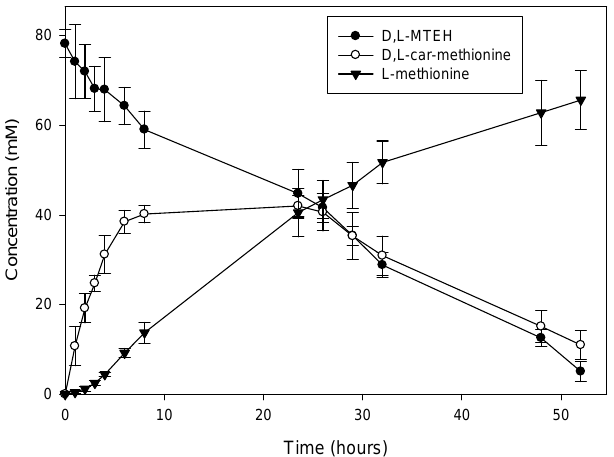
Figure 5. Conversion curves of D , L ‐ 5 ‐ methylthioethylhydantoin into L ‐ methionine by immobilized biocatalyst on IB ‐ 350 (Cycle 1). ( ● ) D , L ‐ 5 ‐ methylthioethylhydantoin, ( ○ ) N ‐ carbamoyl ‐ D ‐ methionine, and ( ▼ ) L ‐ methionine.